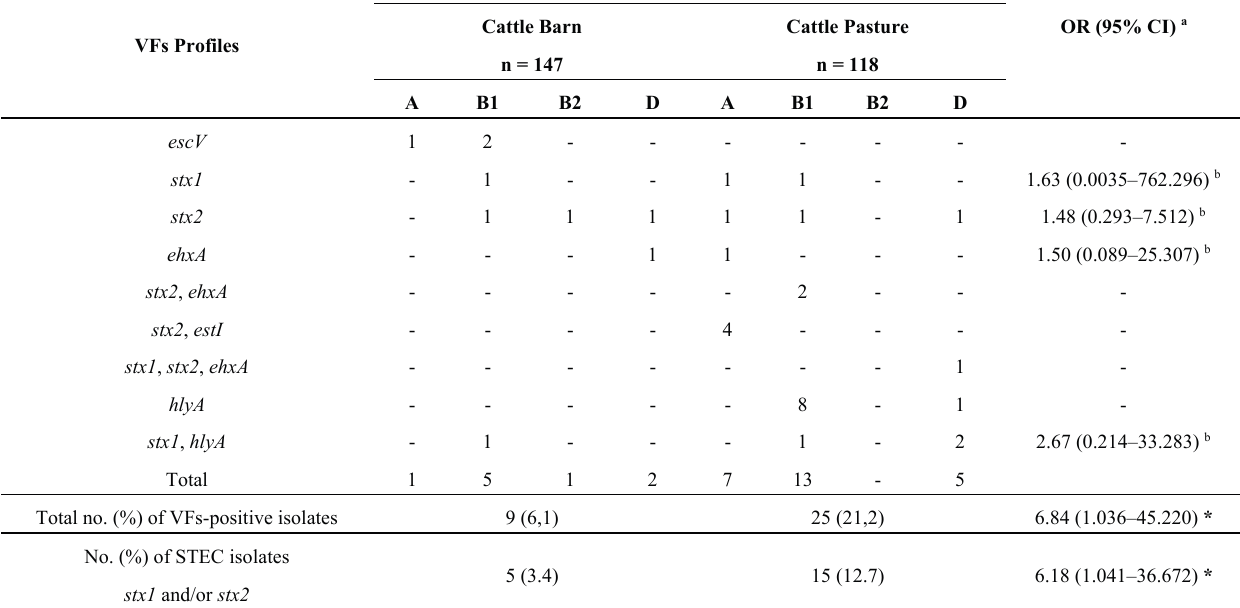
Table 1. Distribution of the profiles of virulence factors. ( A ) Among E. coli isolates in relation to the phylogenetic groups; results from the mixed logit model; ( B ) Among animals with E. coli positive for VFs profiles; results from the logistic model and tests of independence.